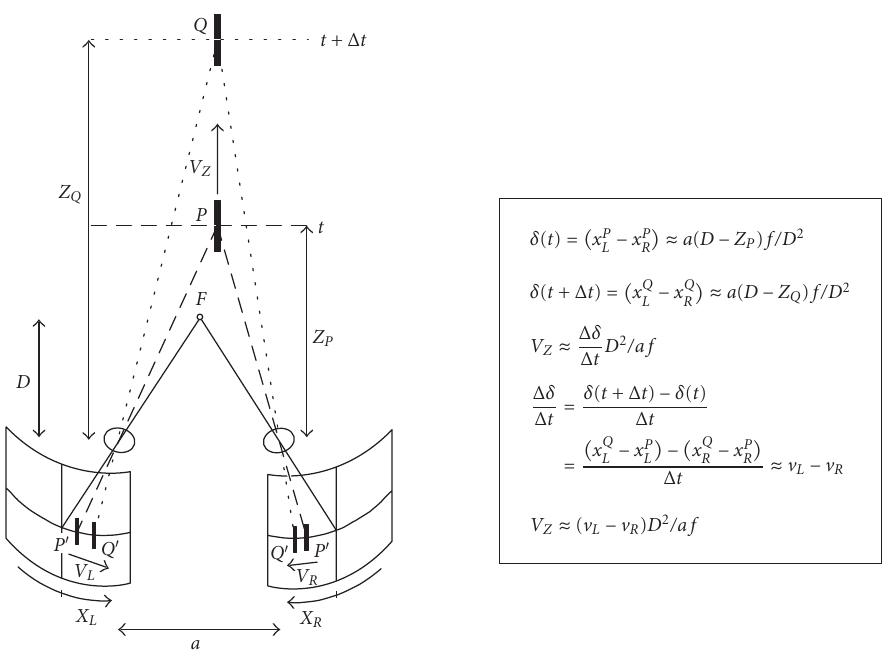
Figure 1: The stereo dynamic correspondence problem. A moving object in the 3D space projects di ff erent trajectories onto the left and right images. The di ff erences between the two trajectories carry information about